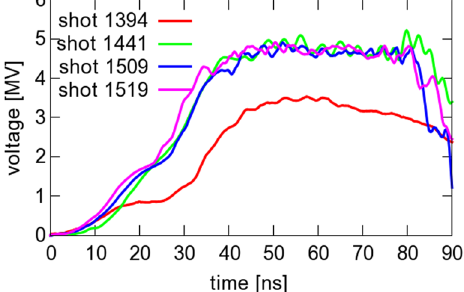
FIG. 5. Measured voltages used to drive four simulations of the SMP diode.